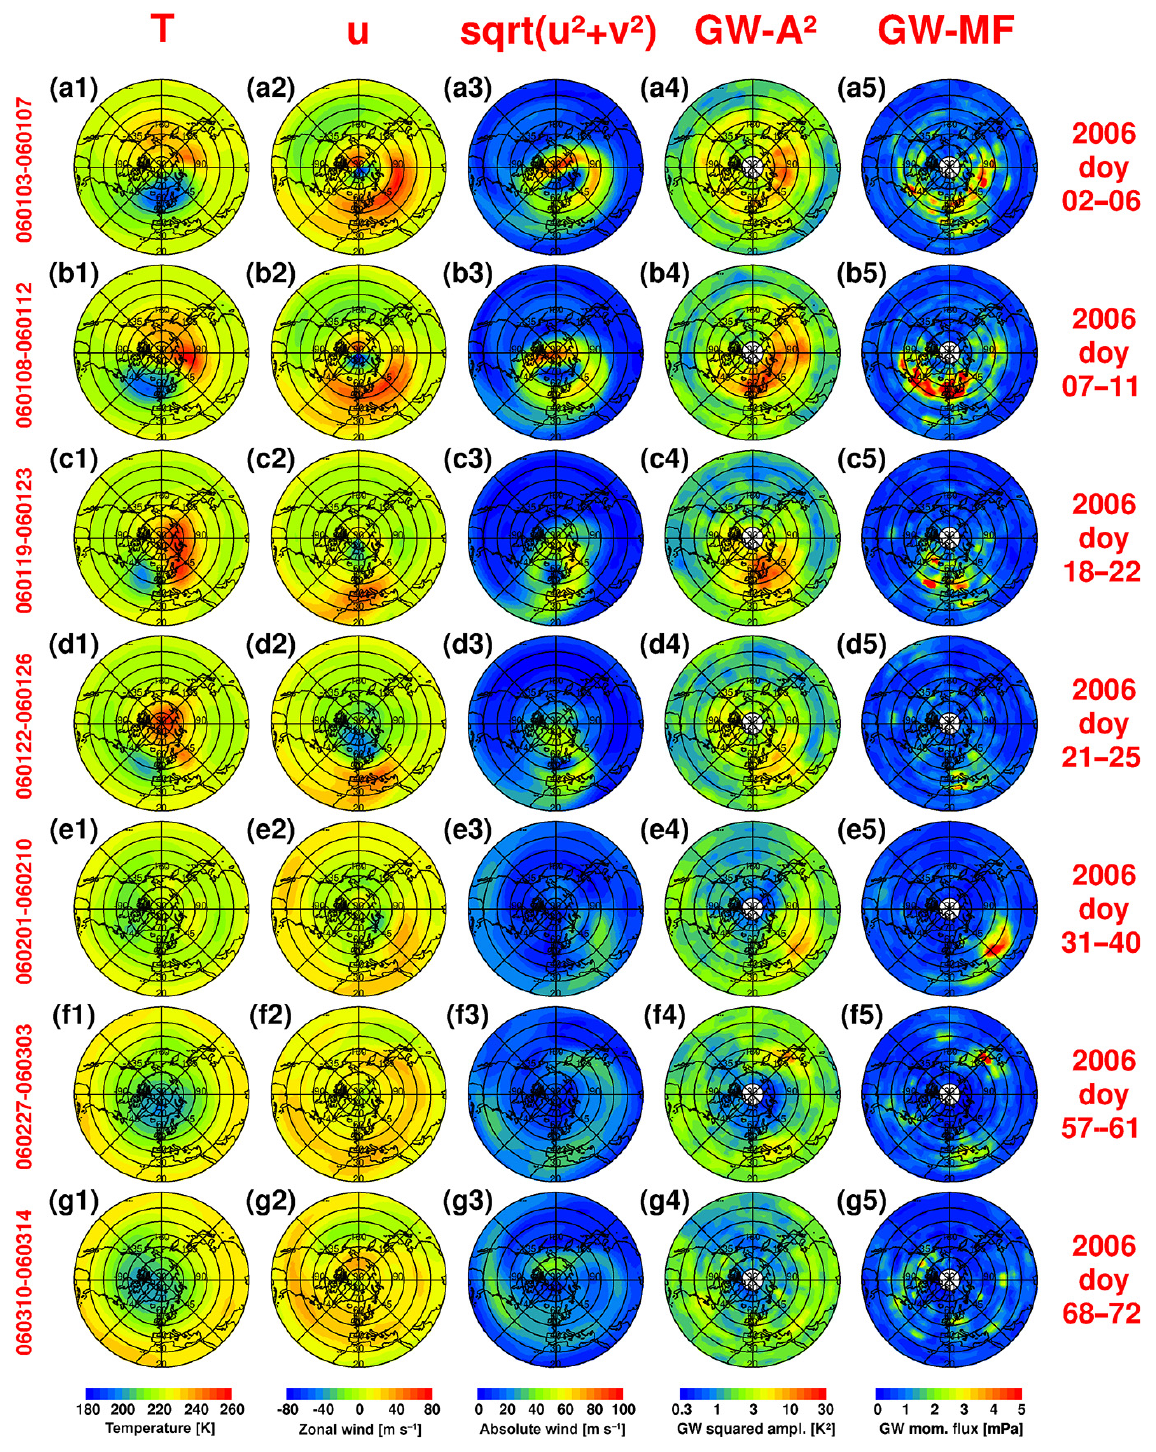
Figure 9. Horizontal distributions at 30km altitude of ERA-Interim temperatures (left column), zonal wind (second column), absolute horizontal wind (third column), and HIRDLS gravity wave squared amplitudes in K 2 on a logarithmic scale (fourth column), as well as HIRDLS gravity wave momentum fluxes in mPa on a linear scale (right column). The different rows represent different periods before, during, and after the central date (21 January) of the 2006 major